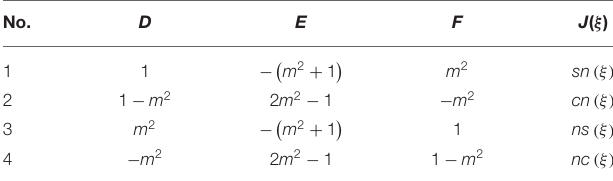
TABLE 1 | Jacobi elliptic function solutions of Equation